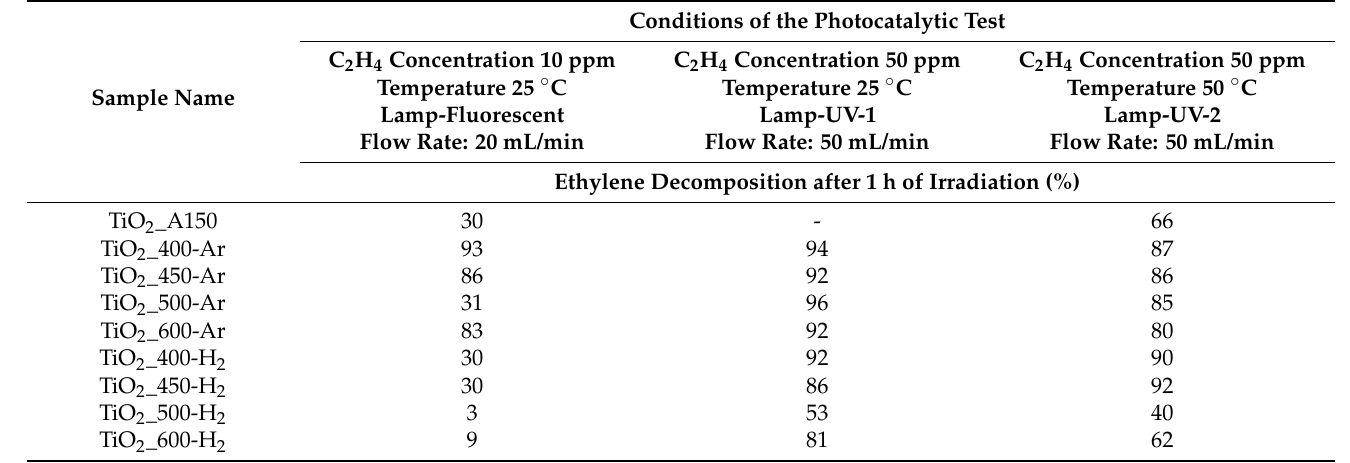
Table 4. Percentage decomposition of ethylene on the titania samples after 1 h of irradiation under different